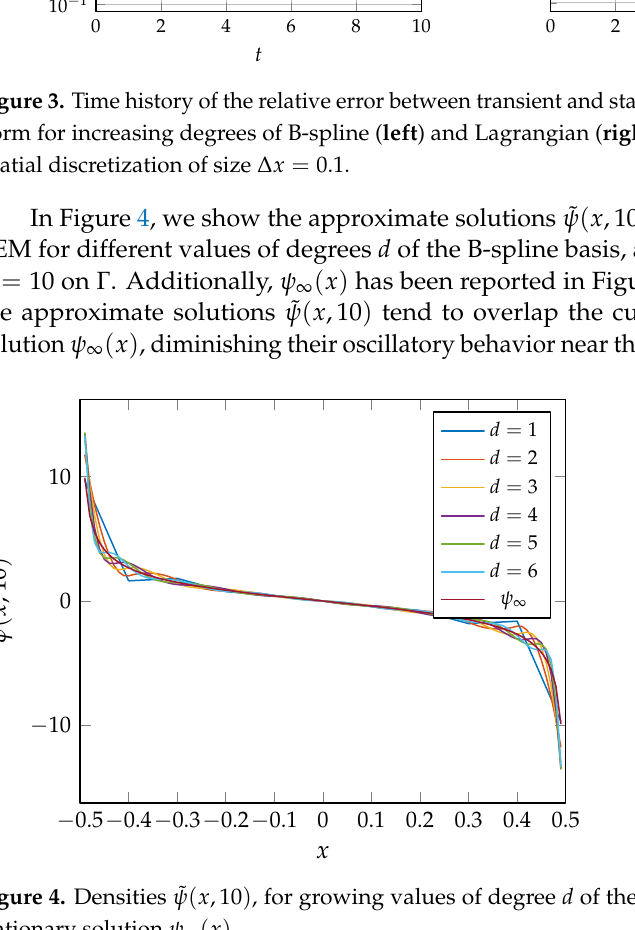
Figure 3. Time history of the relative error between transient and stationary solutions in the H − 1/2 ( Γ ) norm for increasing degrees of B-spline (left) and Lagrangian (right) shape functions on a uniform spatial discretization of size ∆ x = 0.1.